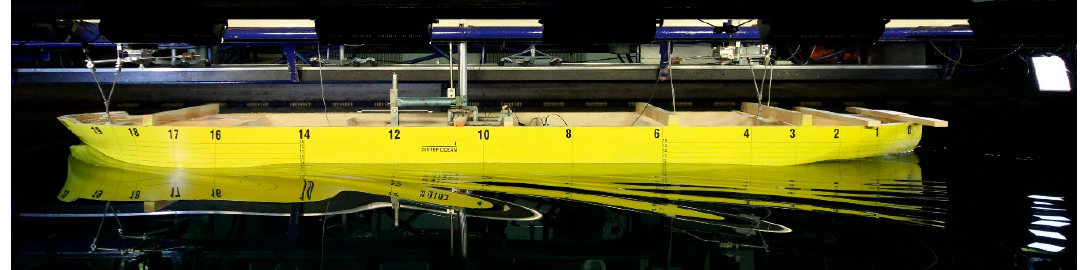
Figure 17. Propulsion test setup with the designed PSS.